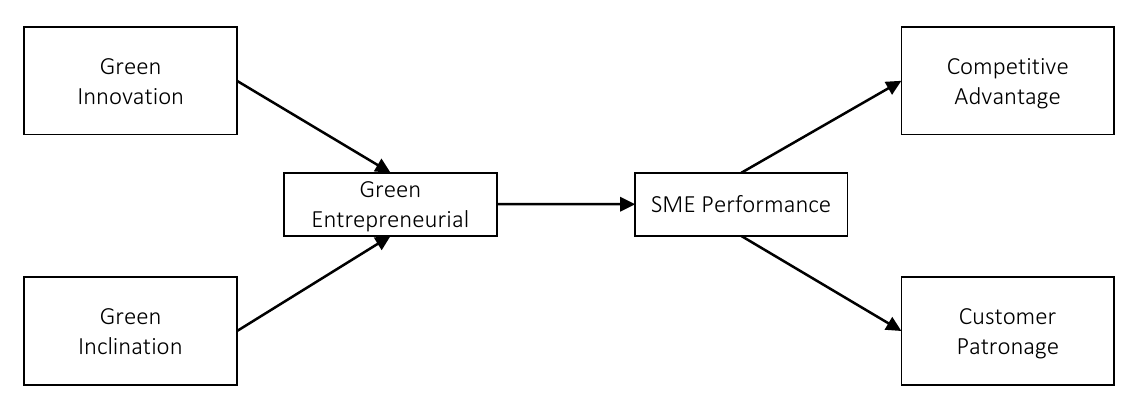
Figure 1. Conceptual